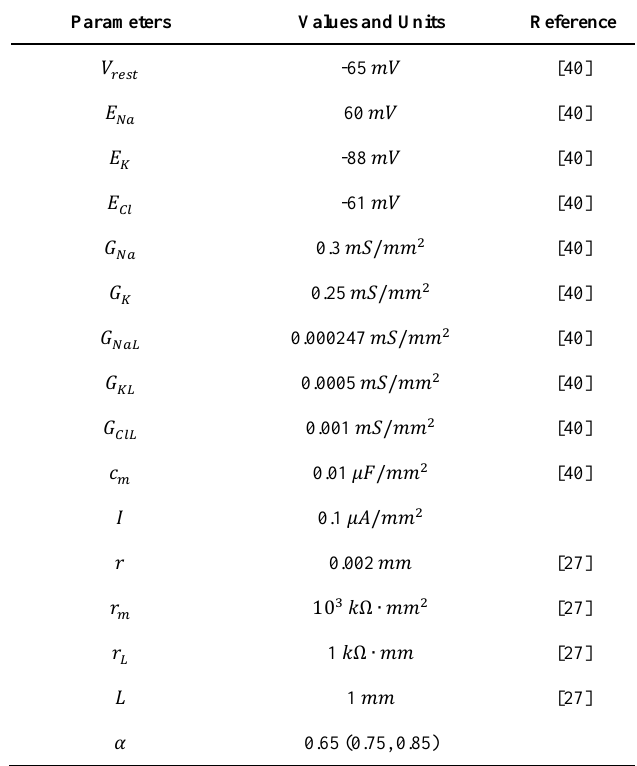
Table 1. List of parameters with corresponding values and physical